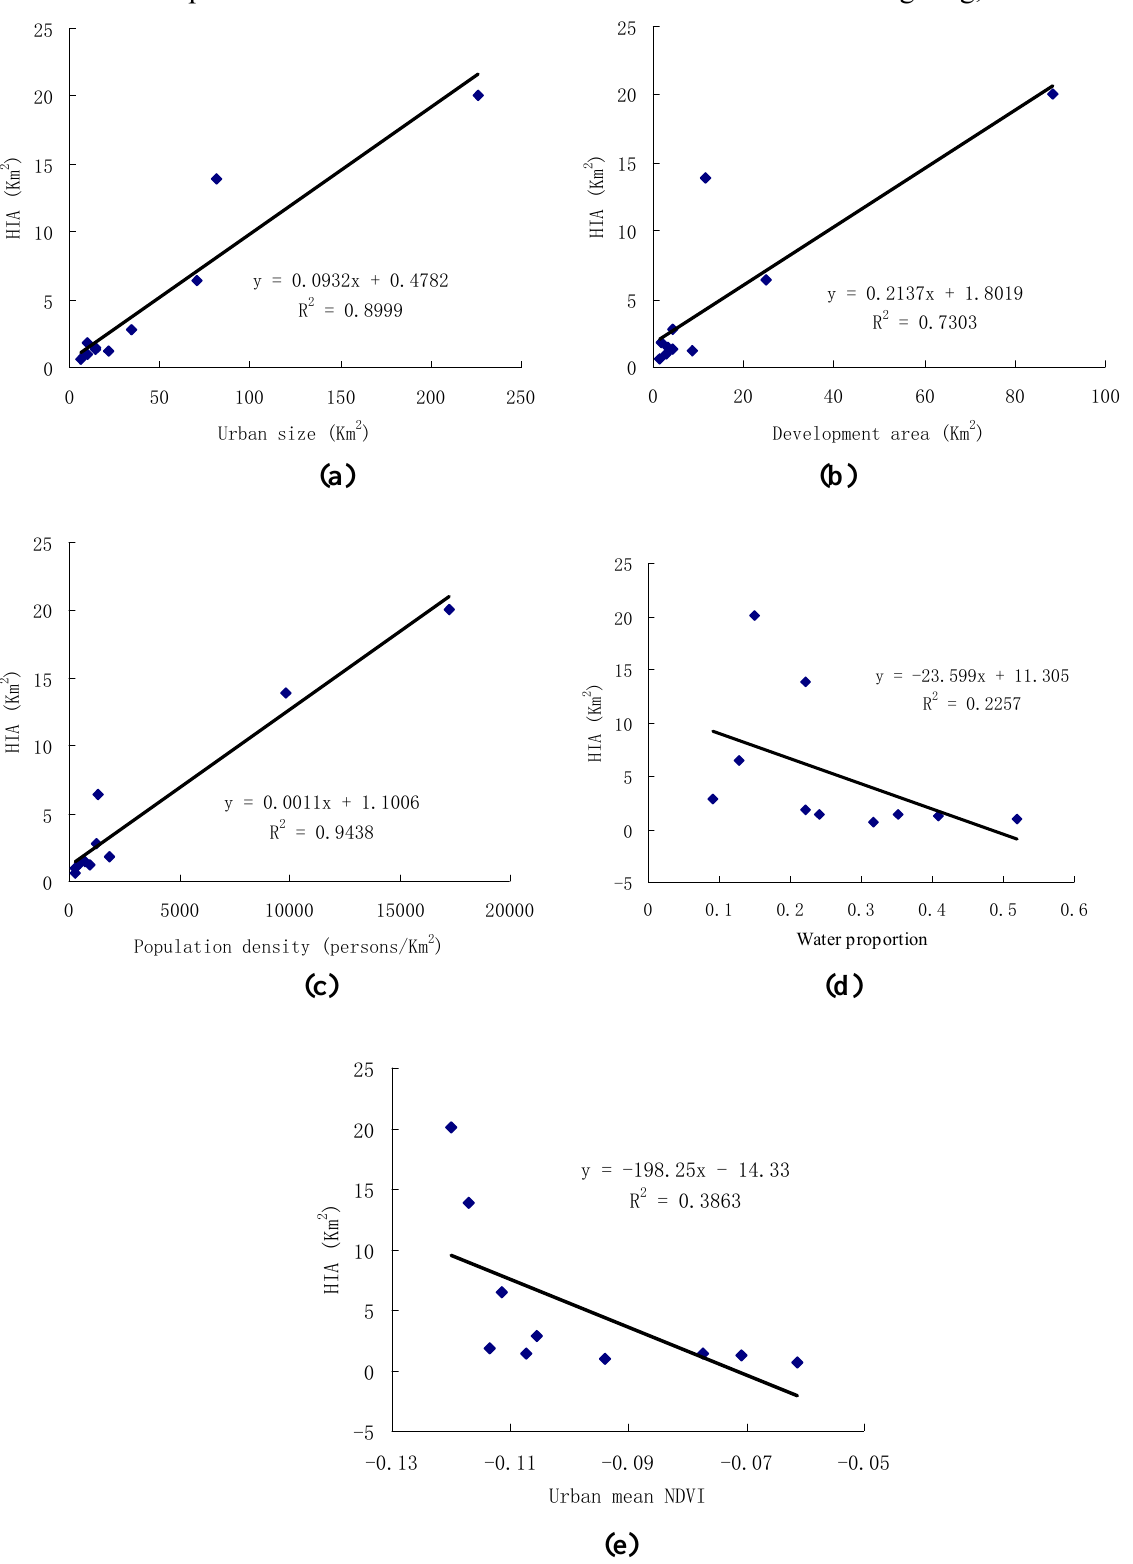
Figure 4. (a) Relationship between HIA and urban size in 10 cities in Guangdong, China. (b) Relationship between HIA and development area in 10 cities in Guangdong, China. (c) Relationship between HIA and urban population density in 10 cities in Guangdong, China. (d) Relationship between HIA and water proportion in ten cities in Guangdong, China. (e) Relationship between HIA and mean NDVI value in ten cities in Guangdong, China.